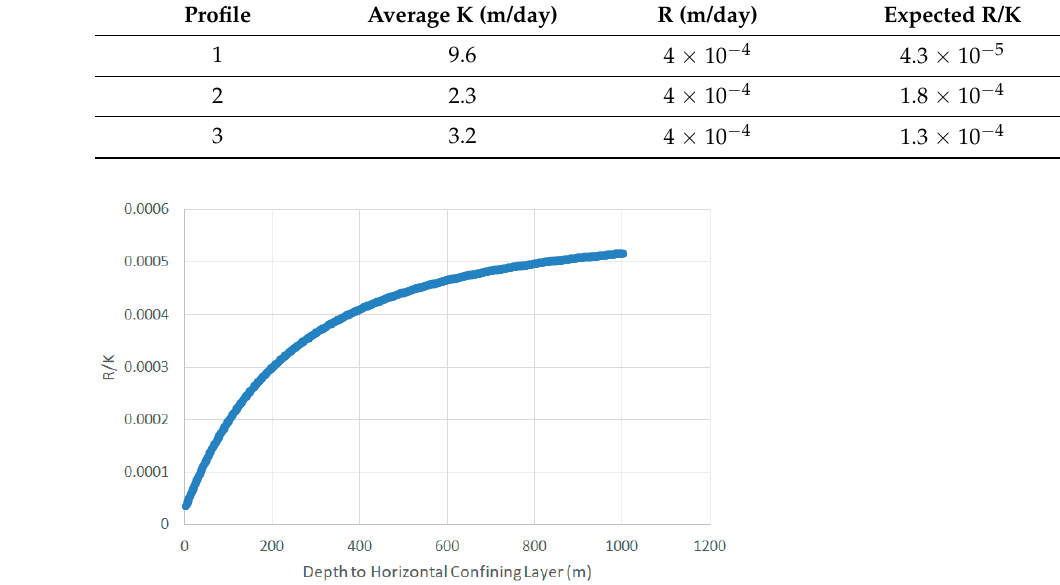
Figure A2. The nonlinear relationship between depth to the horizontal confining layer (D) and the